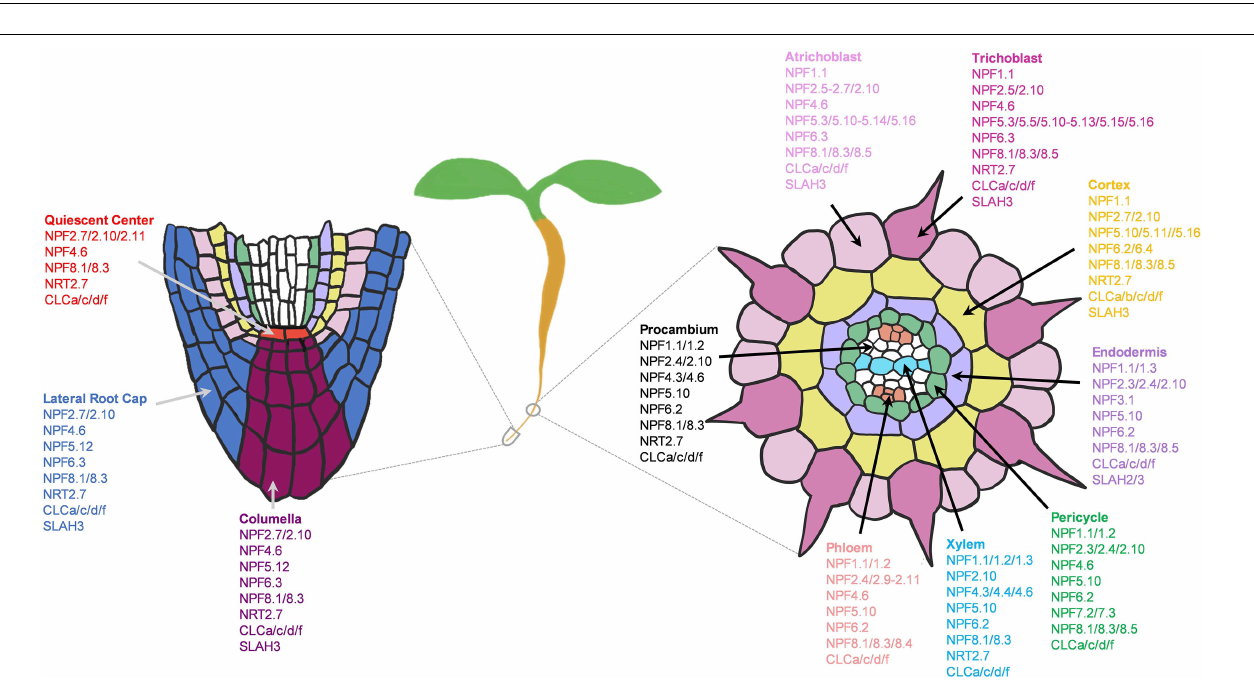
FIGURE 4 | Expression of the (A) CLC antiporters and (B) SLAC1 channels in Arabidopsis root single cells. In dot plots, the circle size represents the proportion (%) of cells expressing a given gene, and the color of scale bar represents the mean expression (natural log +1 pseudocount). The expression of CLCg was not detected in any single cells.